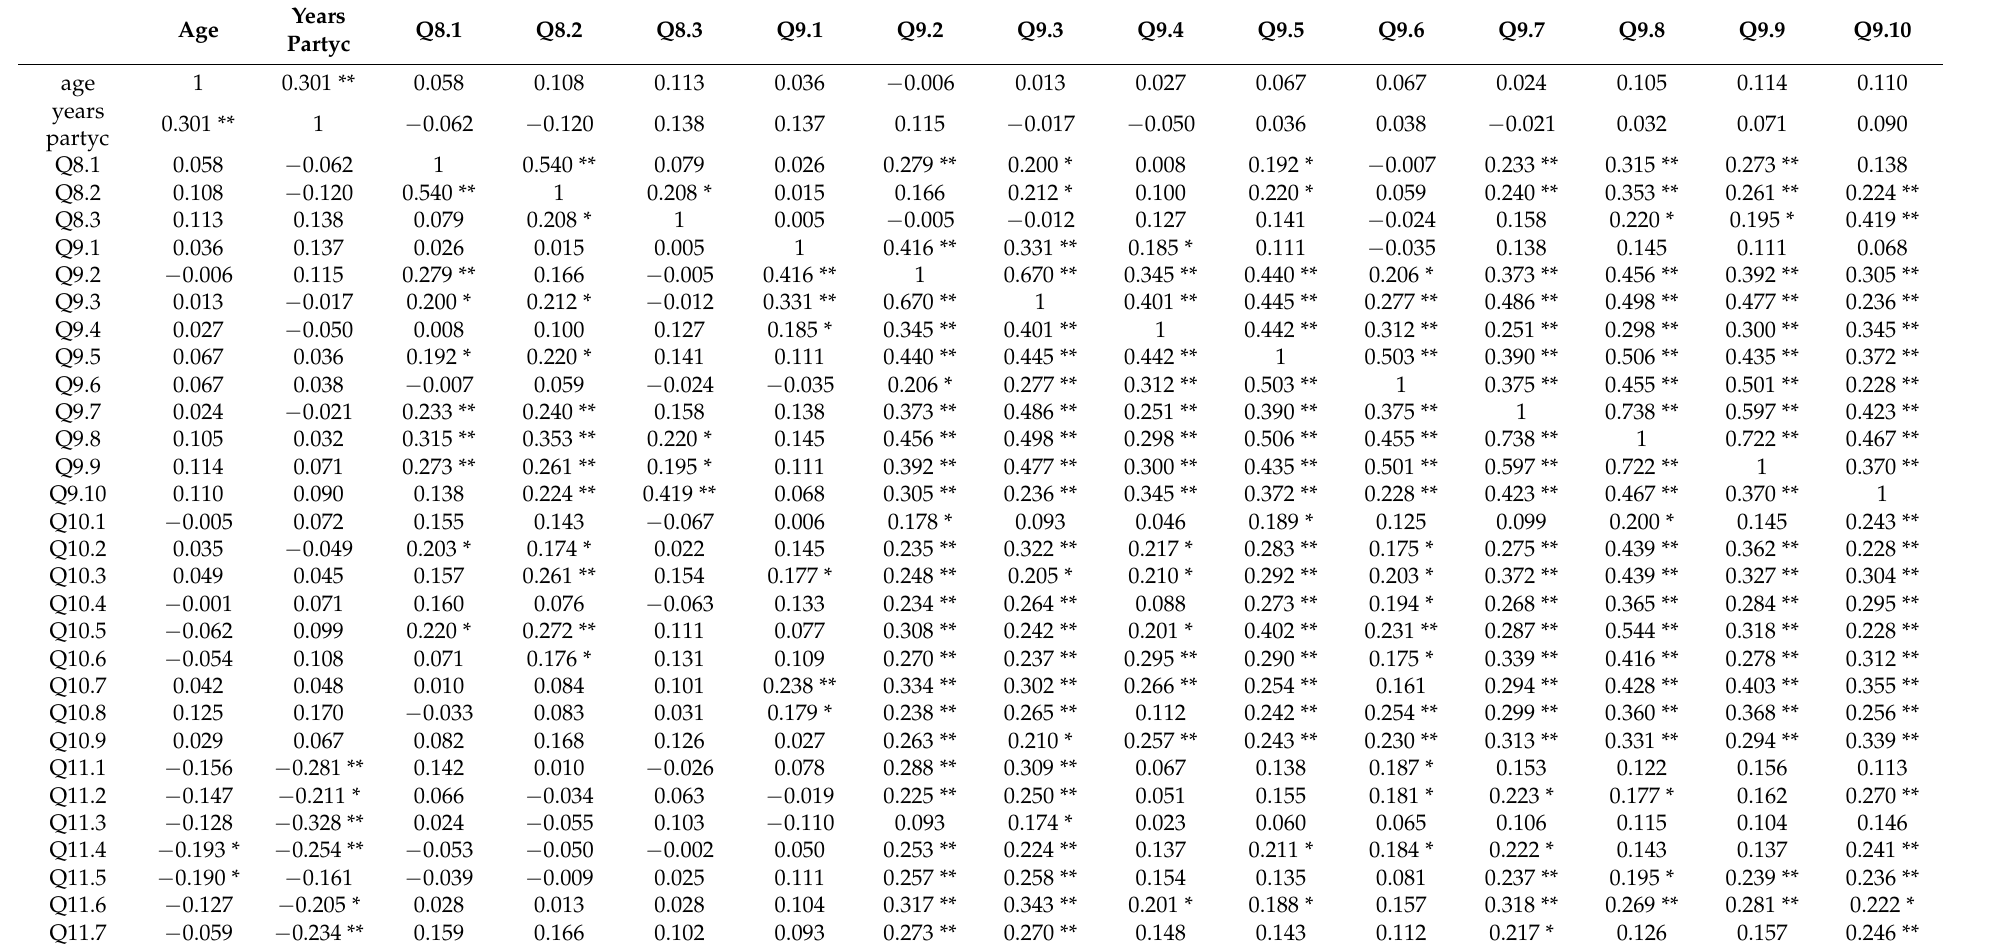
Table A1. Pearson’s correlation matrix, * significant at the alpha 0.05 level, ** significant at the alpha 0.01